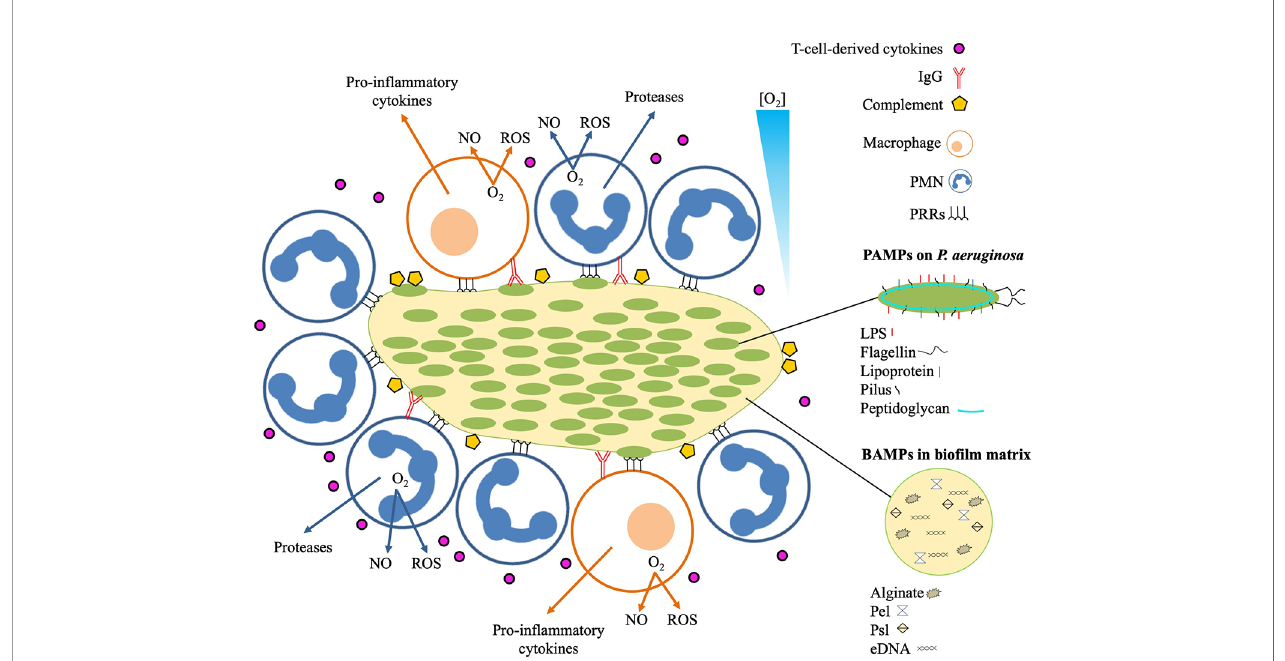
FIGURE 2 | Local immune response to infectious P. aeruginosa bio fi lm. The innate immune response recognizes pathogen associated molecular patterns (PAMPs) expressed on P. aeruginosa , and bio fi lm-associated molecular patterns (BAMPs) present in the bio fi lm matrix. Detection of BAMPs and PAMPs by PMNs and macrophages is mediated by pattern recognition receptors (PRRs). Binding of BAMPs and PAMPs to PRRs stimulates the PMNs and macrophages resulting in consumption of O 2 for liberation of tissue-toxic reactive oxygen species (ROS) and nitric oxide (NO). Additional responses by the PMNs include secretion of proteases that may cause proteolytic tissue lesions while the macrophage may further enhance the in fl ammation by emitting pro-in fl ammatory cytokines such as TNF- a , Il-1, IL-6, IL-8, and IL-12. The effector cells of the adaptive immune response mainly reside distantly such as the T-cells and the B-cells in the secondary lymphoid organs and the plasma cells in the bone marrow. Activated T-cells may release cytokines that further reinforces the in fl ammation by stimulating the accumulation and activation of PMNs and production of IgG. The contribution of the increased accumulation of activated PMNs to the local in fl ammation is further accelerated by binding of antigens to IgG, leading to immune complex mediated stimulation of the PMNs and activation of the classical complement